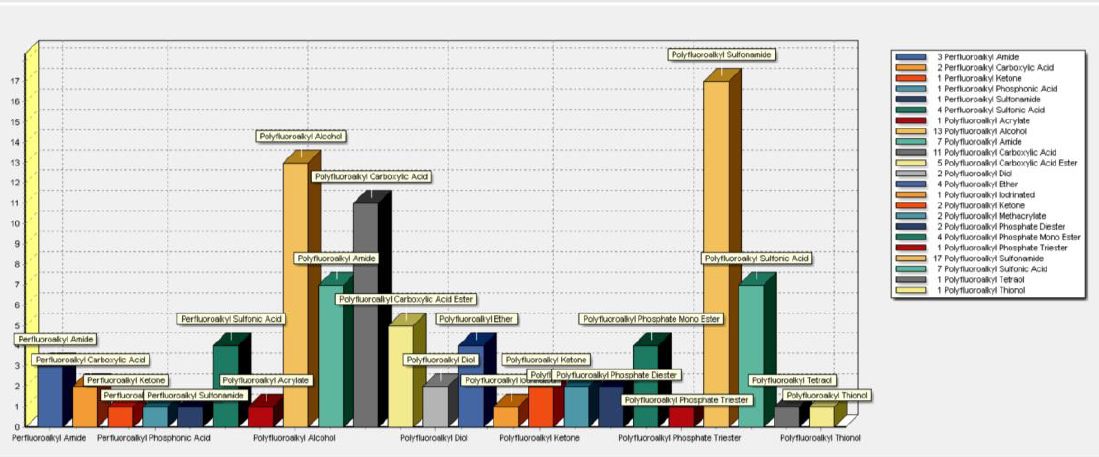
Figure 1. Classification of 97 PFAS found in the open literature biotransformation database, utilizing the Automated PFAS Pipeline